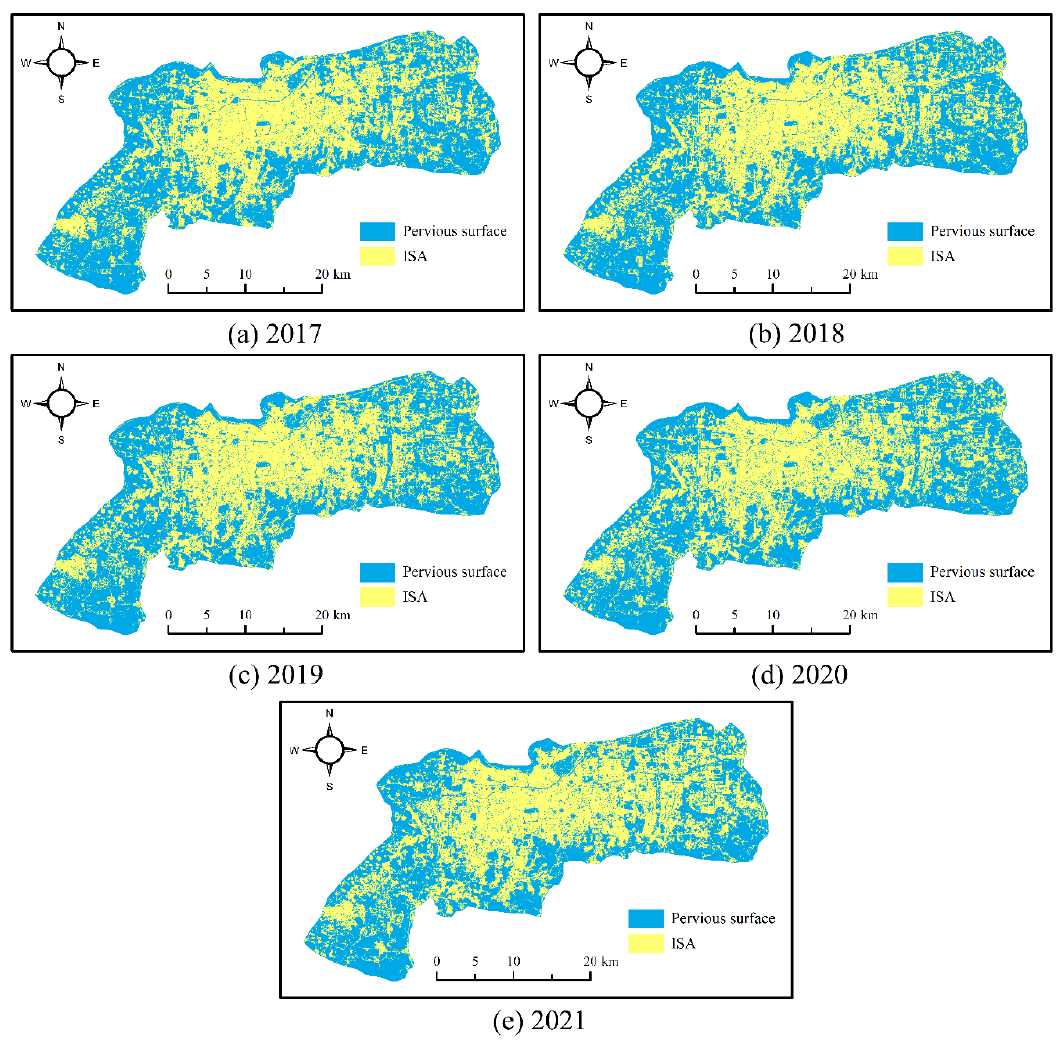
Figure 10. Extraction results of the impervious surface in the central city of Jinan. (a) 2017; (b) 2018; (c) 2019; (d) 2020; (e) 2021.